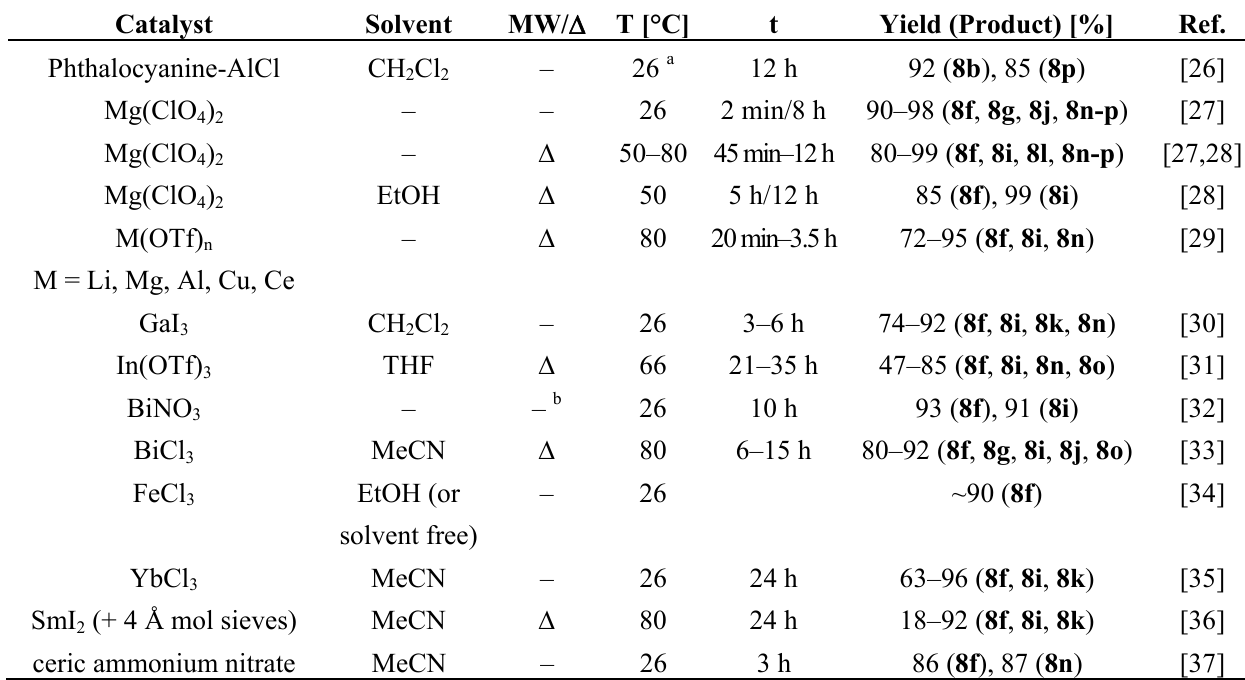
Table 3. Kabachnik–Fields reactions carried out in the presence of